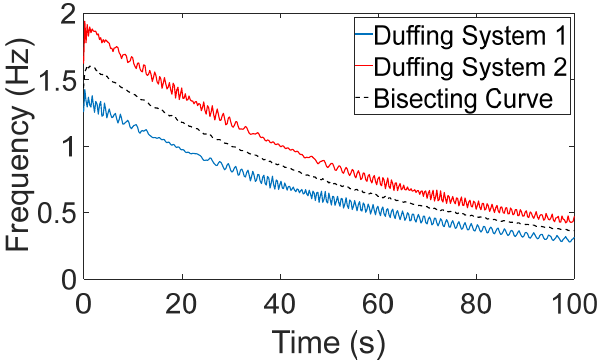
Figure 2. Time–frequency plane of Duffing systems.